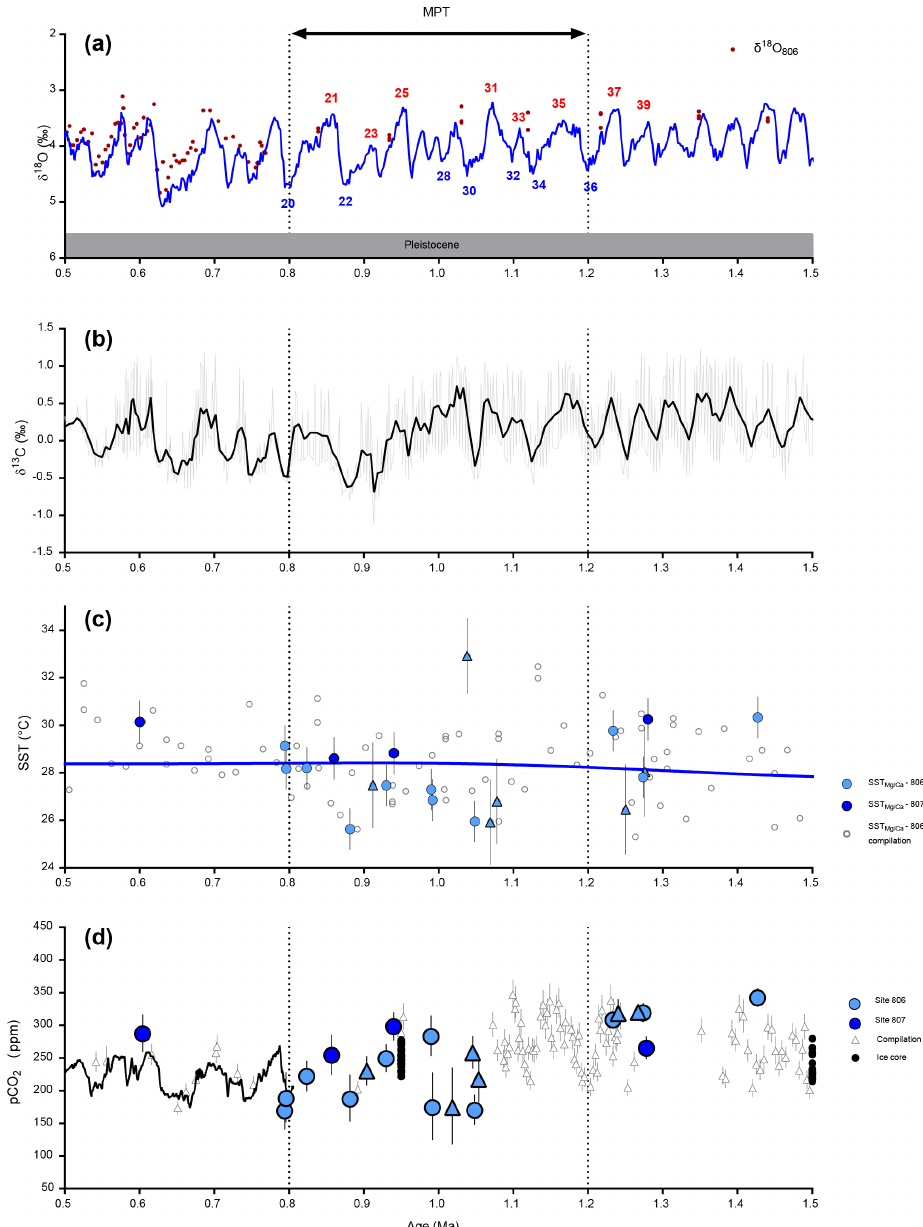
Figure 10. Proxy data from 1.5 to 0.5 million years, including the Middle Pleistocene Transition (MPT), in the Western Equatorial Pacific compared to benthic oxygen isotope data. (a) Benthic δ 18 O (blue line – stack from Lisiecki and Raymo, 2005). (b) Benthic δ 13 C (black line – compilation from Zachos et al., 2008). (c) – (d) Color indicates the site (filled light blue = 806, filled dark blue = 807), symbols represent the species (circle = T. sacculifer and triangle = G. ruber ), filled grey squares (compilation A) are recalculated data based on Sosdian et al. (2018) at site 872. (c) SST reconstructed at ODP Sites 806 and 807 using Mg / Ca ratios (see Supplement for reconstruction details), open symbols are reconstructed temperatures based on literature Mg / Ca at site 806 (see text or Fig. 4). (d) Reconstructed p CO 2 (ppm) from this study (blue symbols) using boron-based pH and alkalinity from Caves et al. (2016). Propagated uncertainties are given by Eq. (S17). In black are published estimates from ice core data (line – Bereiter et al., 2015; black circles – Yan et al., 2019). Open triangles (compilation B) are from the compilation by Rae et al. (2021). Data for compilation B are from Foster (2008); Hönisch and Hemming (2009); Seki et al. (2010); Foster et al. (2012); Badger et al. (2013); Greenop et al. (2014); Martínez-Botí et al. (2015a); Chalk et al. (2017); Dyez et al. (2018); Sosdian et al. (2018); Greenop et al. (2019); de la Vega et al. (2020).